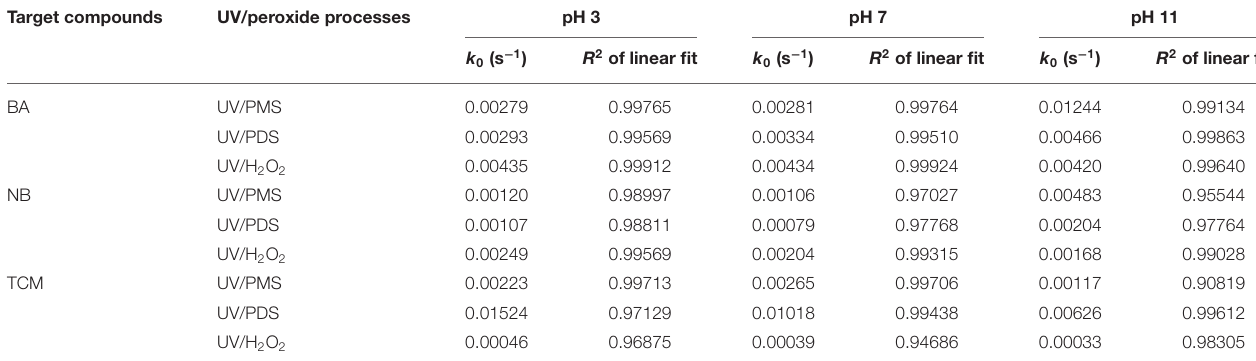
TABLE 4 | Pseudo-first-order rate constant ( k 0 ) of BA, NB, and TCM degradation in UV/peroxide processes under acidic, neutral, and alkaline conditions.